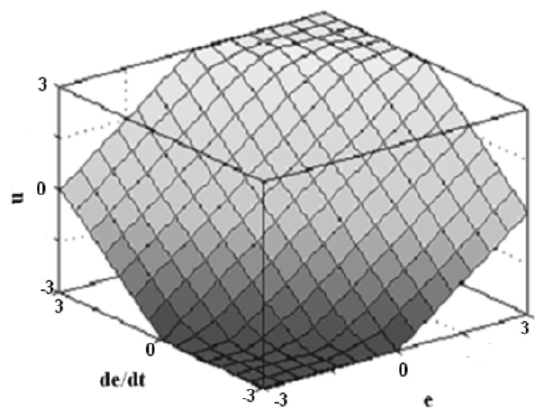
Figure 7. Curves for changes in the output variable control object by using classical PID and the PID controller proposed in this